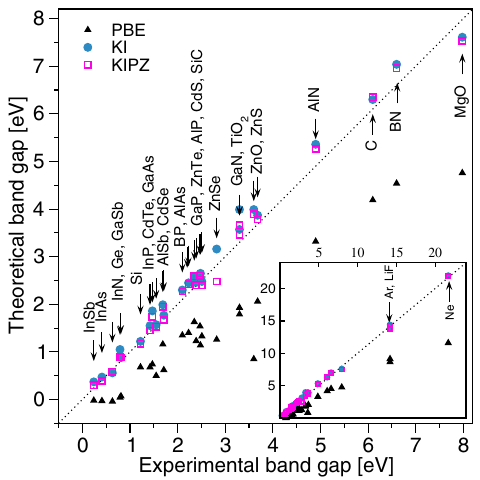
FIG. 2. Band gaps of 30 semiconductors and insulators, calculated using PBE, KI, or KIPZ functionals, compared with available experimental data, shown in an energy range between − 0 . 5 and 8.2 eV. A wider energy range (up to 22 eV) is shown in the inset.